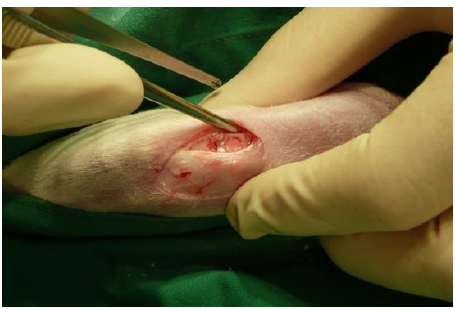
Figure 9. Intraoperative view on the chondral defect filled with the implanted membrane.